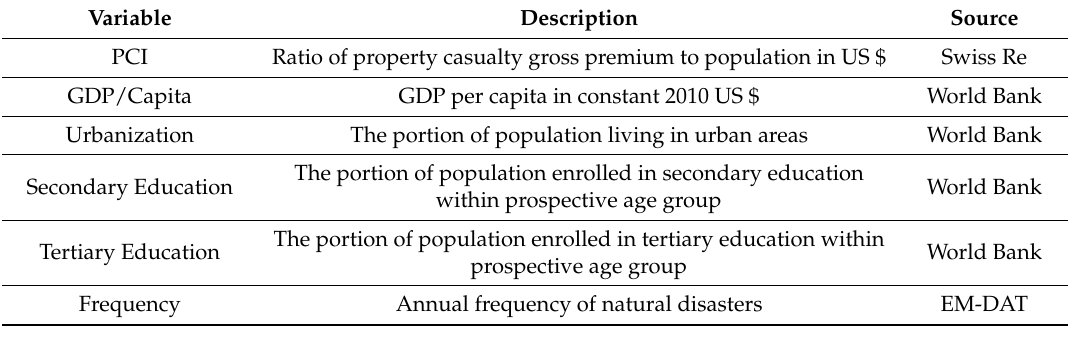
Table A2. Data definitions.